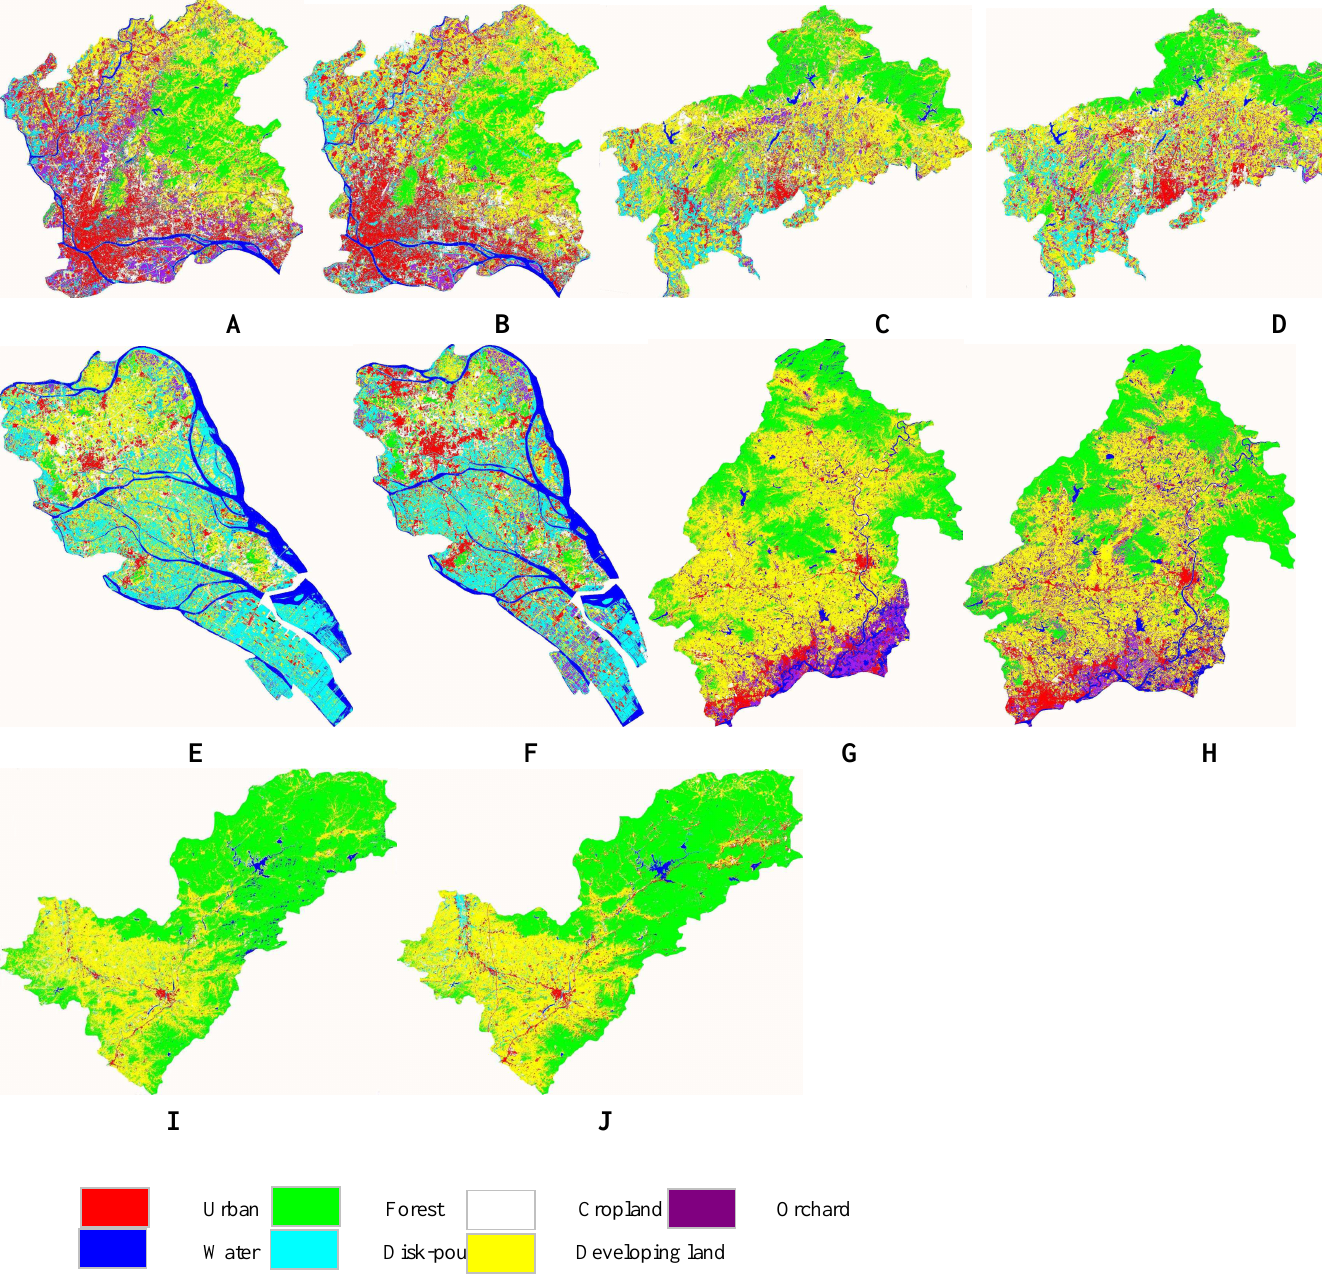
Figure 2. The classification images of land use in 1998 and 2003 for five administrative areas in Guangzhou (A: Guangzhou 1998; B: Guangzhou 2003; C: Huadu 1998; D: Huadu 2003; E: Conghua 1998; F: Conghua 2003; G: Zengcheng 1998; H: Zengcheng 2003; I: Panyu 1998; J: Panyu